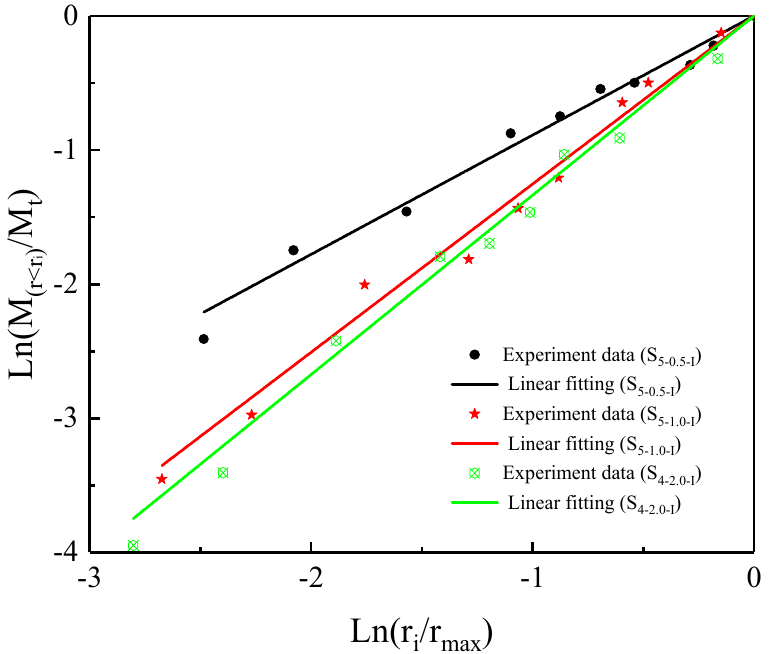
Figure 11. Fractal characteristics of fragments from S 5 series samples. Table 2. Fractal fitting of cemented rock samples with different PSDs. Sample No. Linear Fitting Formula R